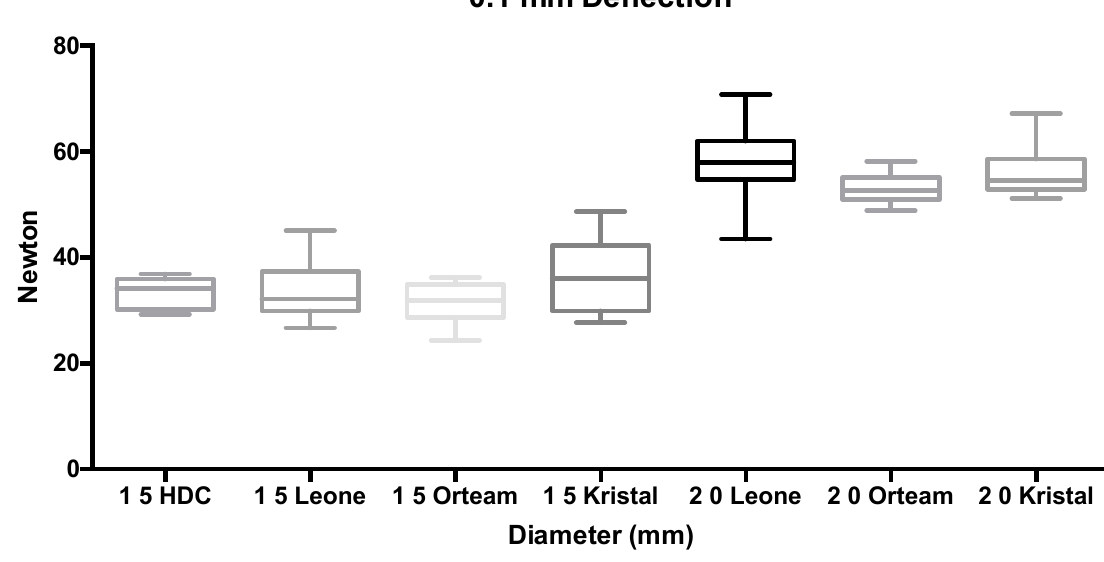
Figure 3. Box plot of groups tested at 0.1-mm deflection (N).